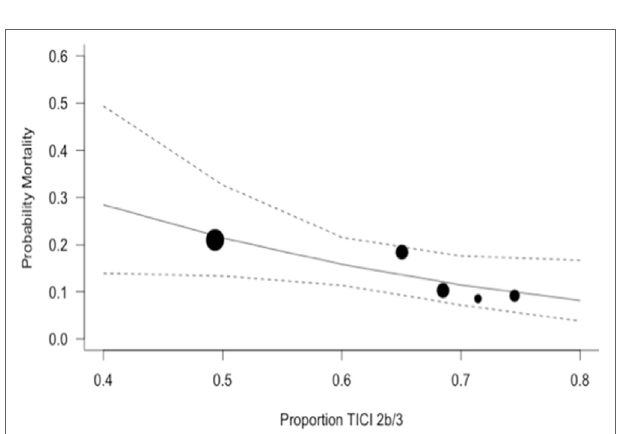
FigUre 5 | Predicted probability of death by modified thrombolysis in cerebral ischemia grade 2b/3, with dashed line showing 95% CI, and size of markers inversely proportional to each within-trial SD (intention-to-treat analysis).